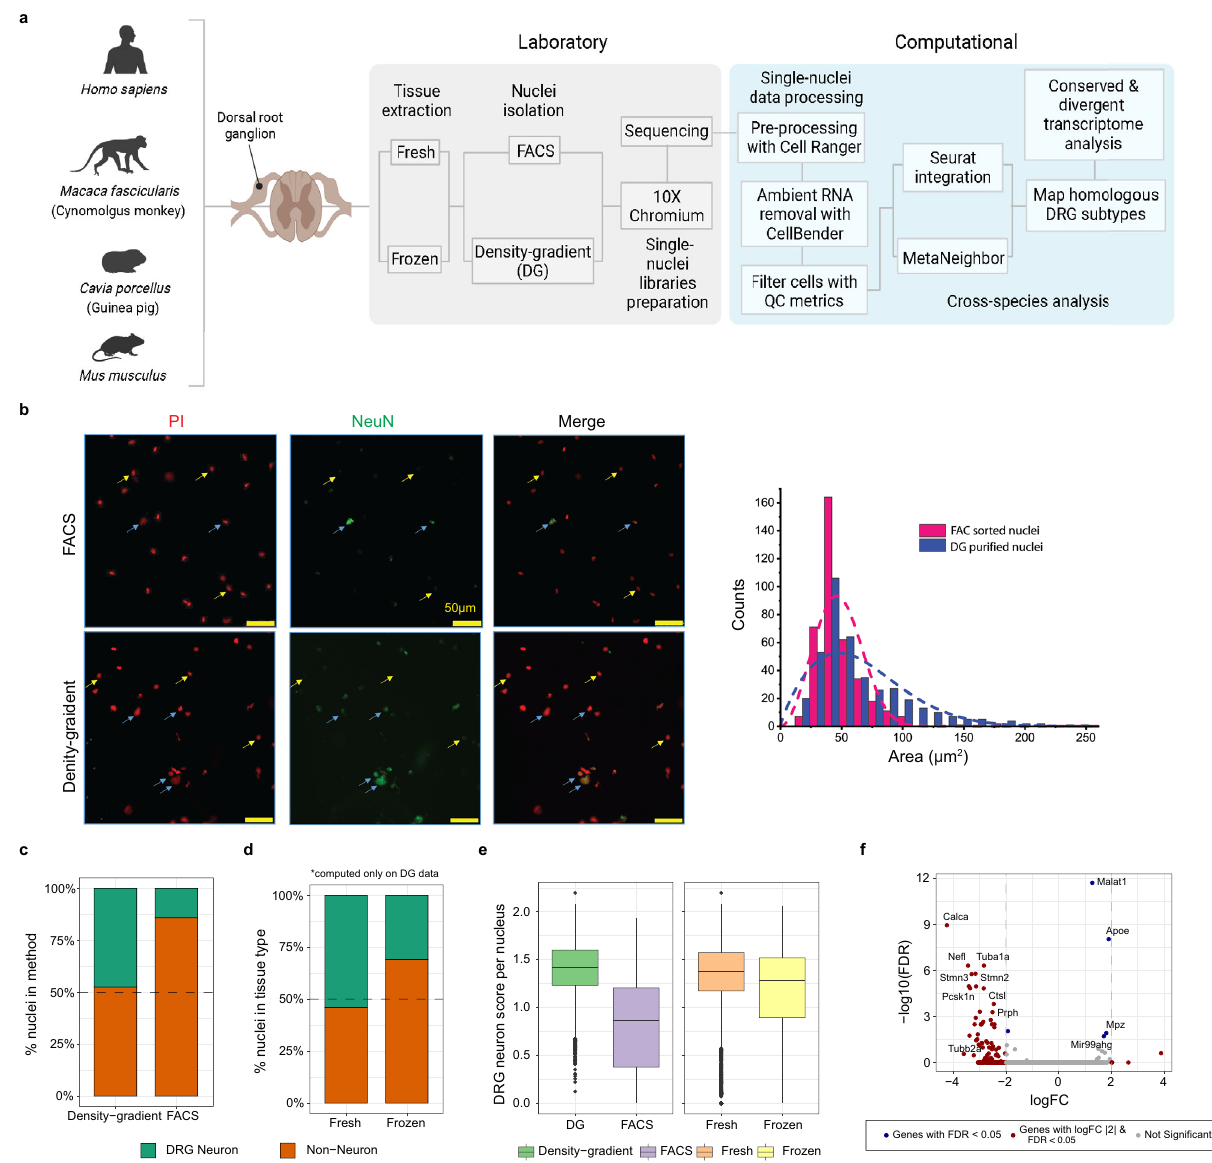
Fig. 1 | Comparison ofnuclei isolation methods and tissue types in dorsal root ganglia single-nucleus RNA-seq. a Overview of laboratory and computational work fl ow. The graphic was created with BioRender.com b Representative micro- graphs of nuclei from FACS and density-gradient (DG) protocols. Blue arrows indicate neuronal nuclei(PI+ and NeuN+)and yellow arrows indicate non-neuronal nuclei(PI+andNeuN − ).Distributionofnucleisizebycapturemethod.Dottedlines represent smoothed distributions of binned data. The experiment was repeated 4 times independently with similar results. c – e Summary metrics computed for dif- ferent nuclei isolation methods and tissue types in mouse data. c , d Relative cell-